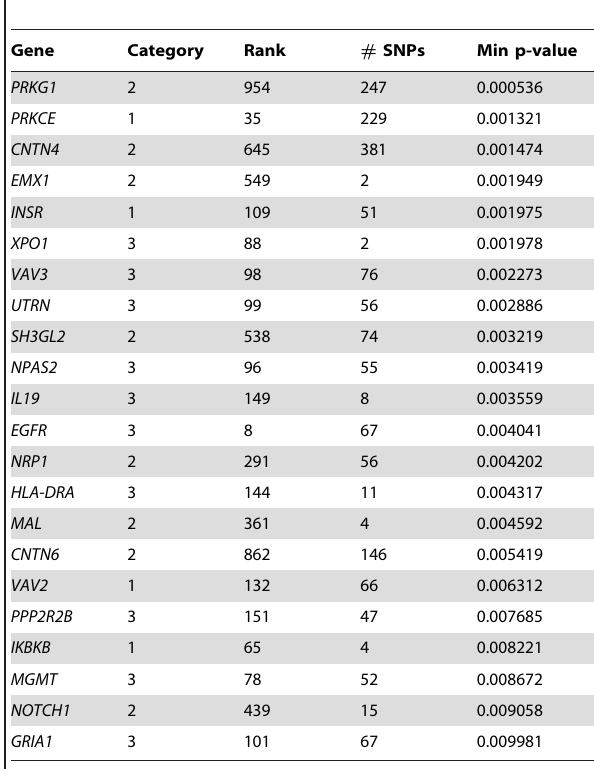
Category 1: genes are both highly ranked and involved in neurodevelopment. Category 2: genes are exclusive to neurodevelopment. Category 3: genes are exclusively highly ranked (see details in Materials and Methods).